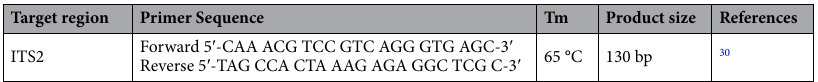
Table 3. Details of species specific primer of T.